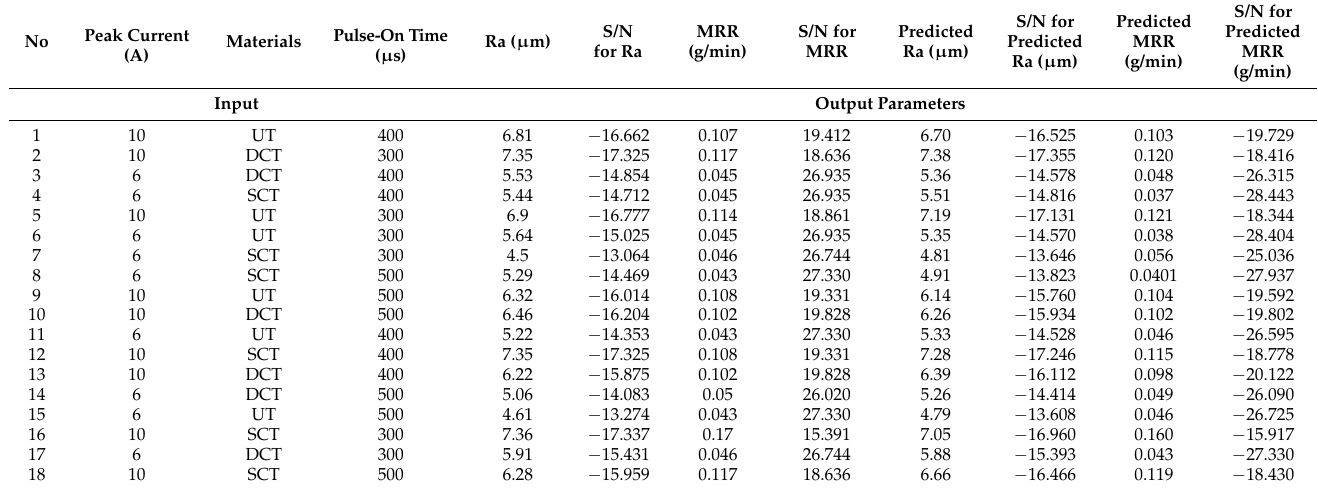
Table 7. Input and output parameters of Hastelloy C22 alloy according to L 18 orthogonal